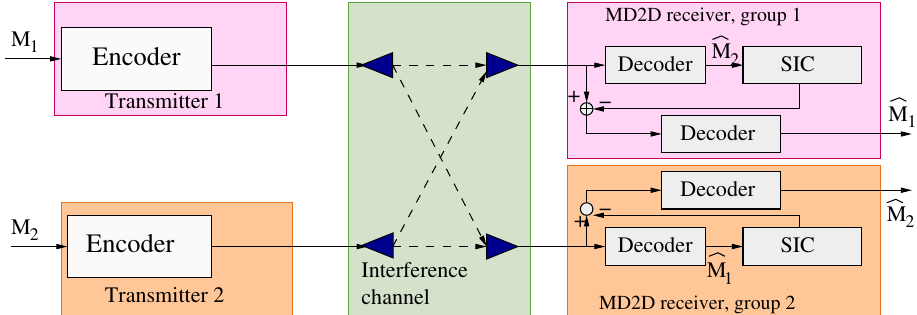
Figure 2. Communications architecture for the NOMA-SIC MD2D